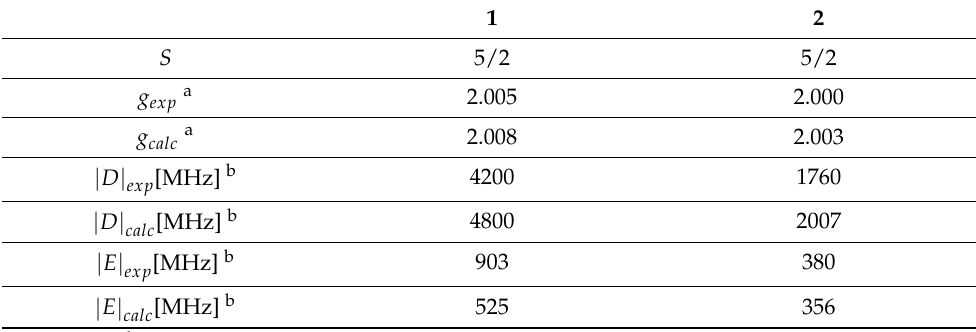
Table 3. Experimental and calculated EPR parameters for polycrystalline complexes 1 and 2